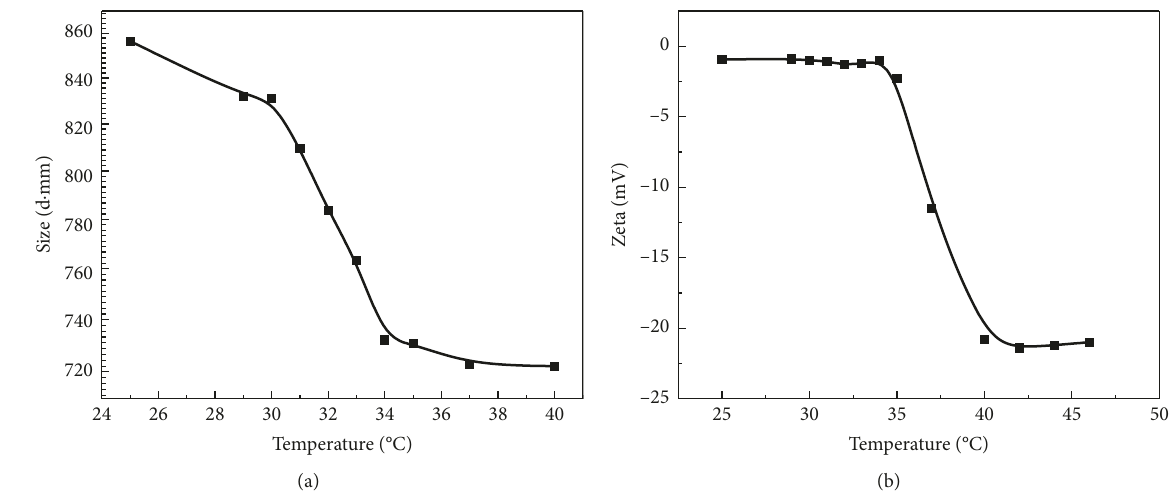
Figure 7: The temperature-dependent (a) average size and (b) Zeta potential of the SiO